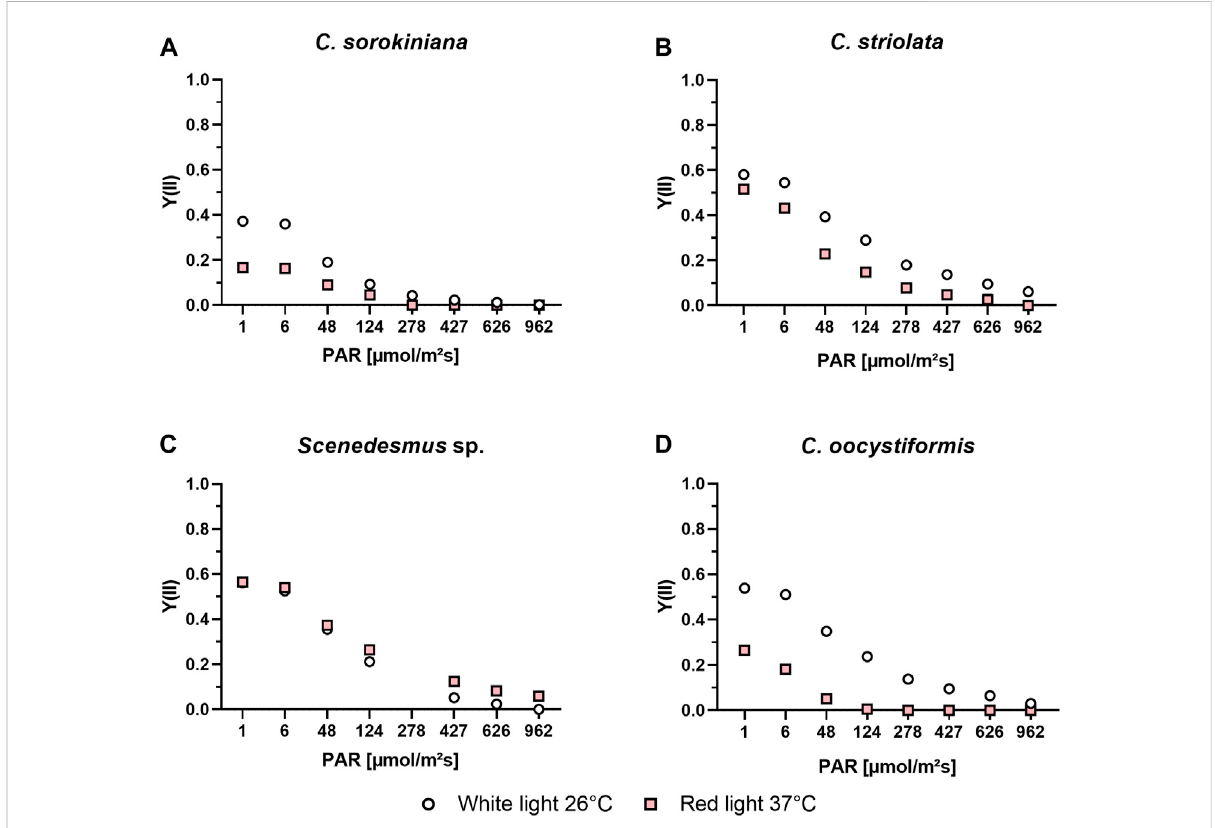
FIGURE 3 PAM light curve measurements of C. sorokiniana (A) , C. striolata (B) , Scenedesmus sp. (C) and C. oocystiformis (D) in suspension culture under both optimal (white light and 26 ° C) and mammalian cell-compatible (red light and 37 ° C) conditions in TP